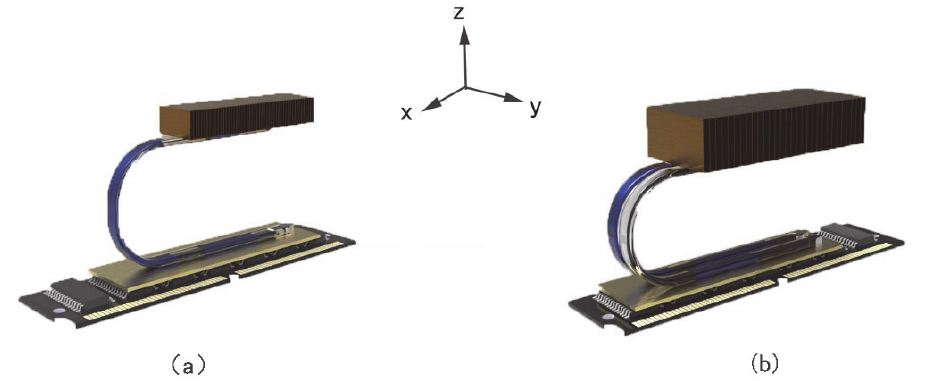
Figure 3. Position of the heat sink: ( a ) 0°; ( b ) 90°.